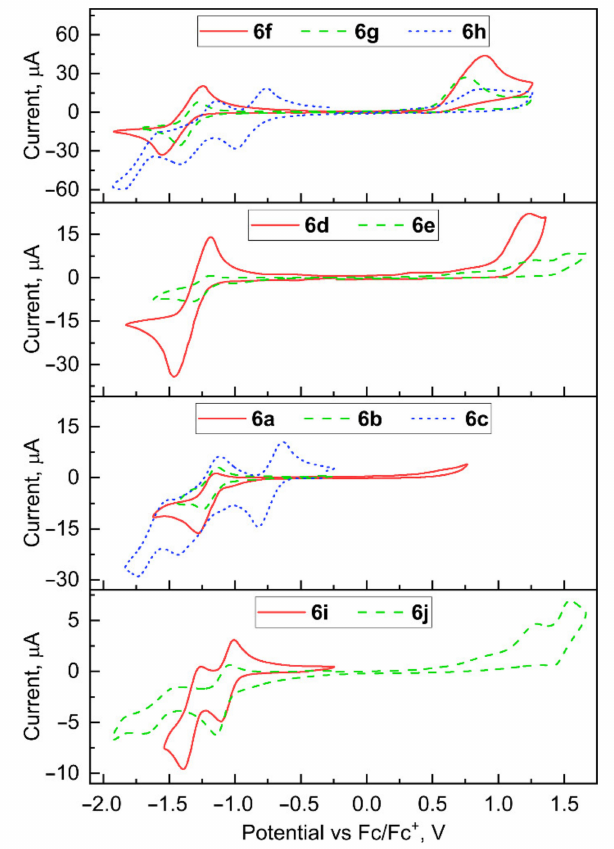
Figure 3. Cyclic voltammograms of BODIPYs 6a – j